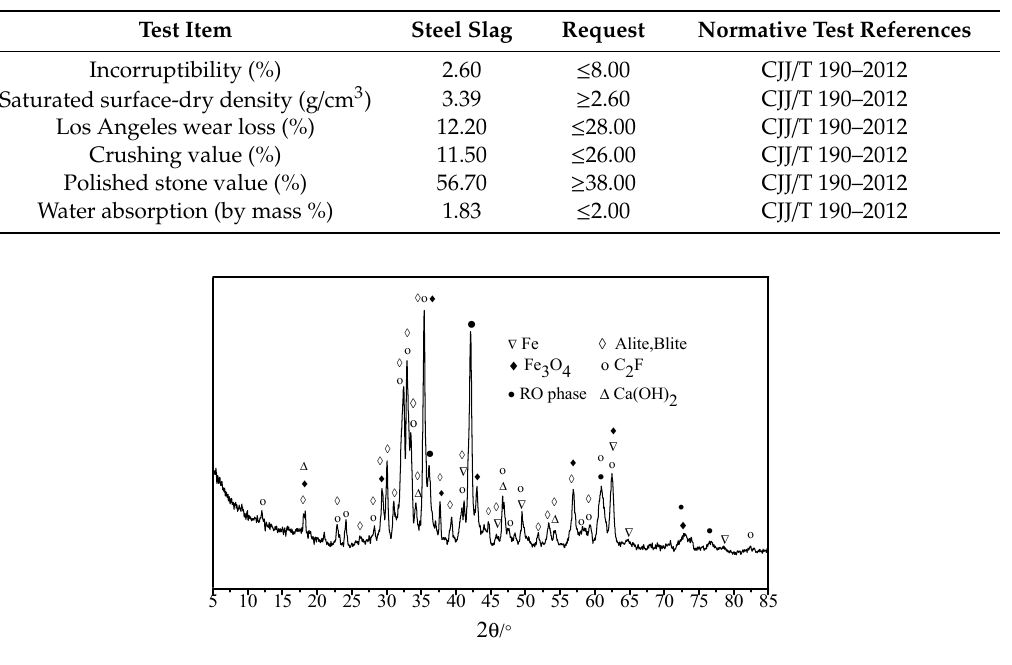
Table 2. Technical indices of coarse aggregates.